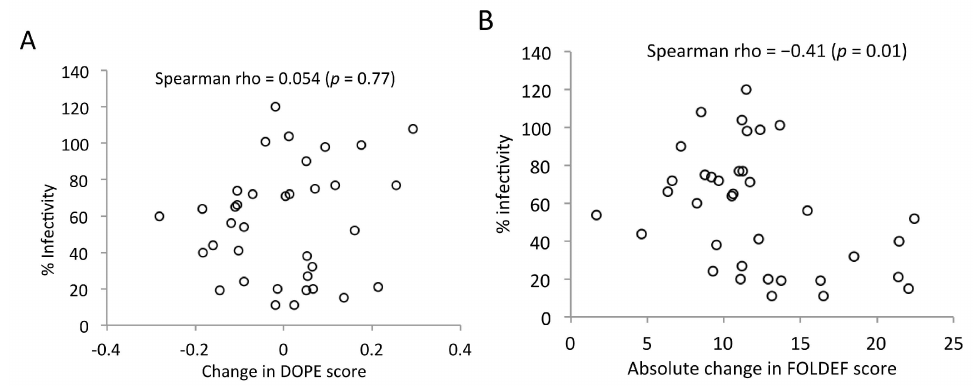
Figure 5. Relationship between viral infectivity and change in stability compared to the reference structure. As predicted by ( A ) DOPE and ( B ) FOLDEF. Each open circle represents a point mutation (viral infectivity data taken from